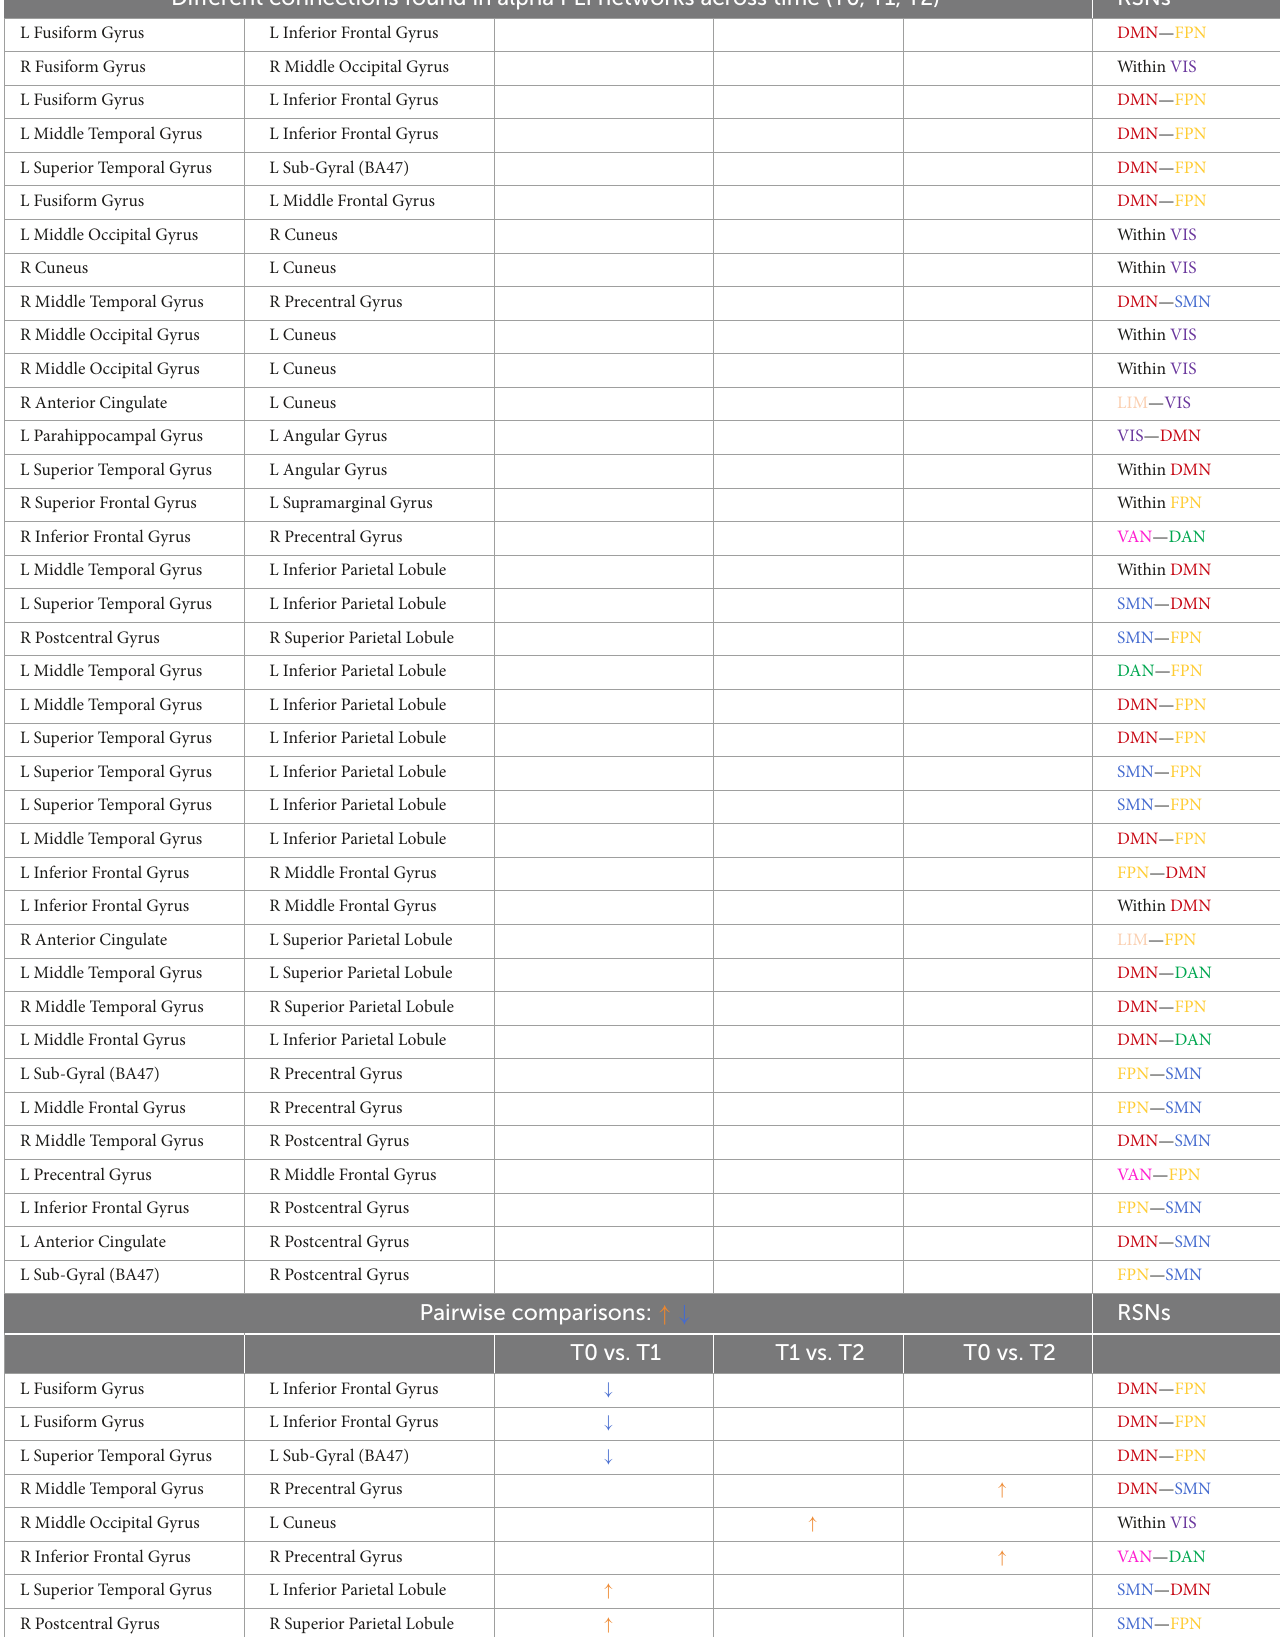
TABLE 3 Different connections found in alpha PLI networks across time (T0, T1, T2) and after pairwise comparisons (L denotes left hemisphere; R denotes right hemisphere). Different connections found in alpha PLI networks across time (T0, T1, T2)